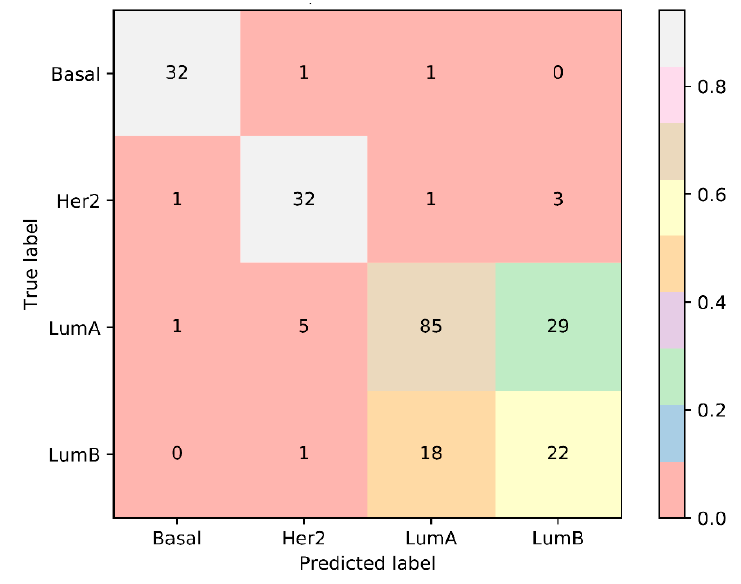
Figure 4. The confusion matrix yielded by the SVM with top 40 features.